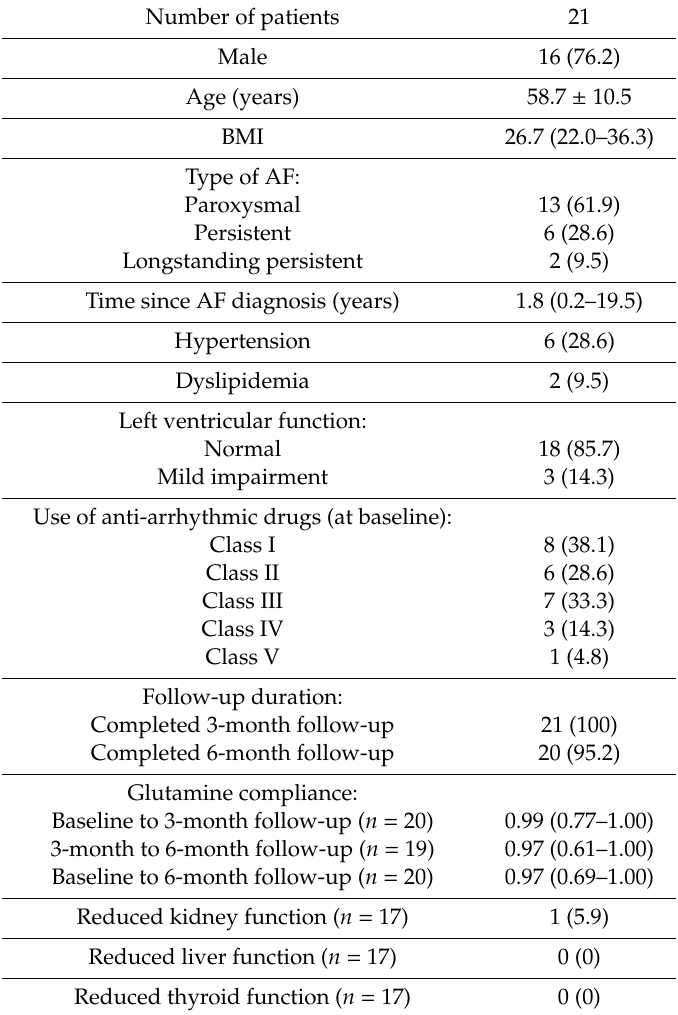
Table 1. Patient